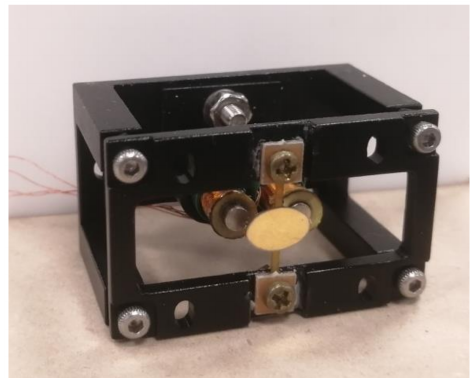
Figure 4. Prototype of the external electromagnet FPCB micromirror.